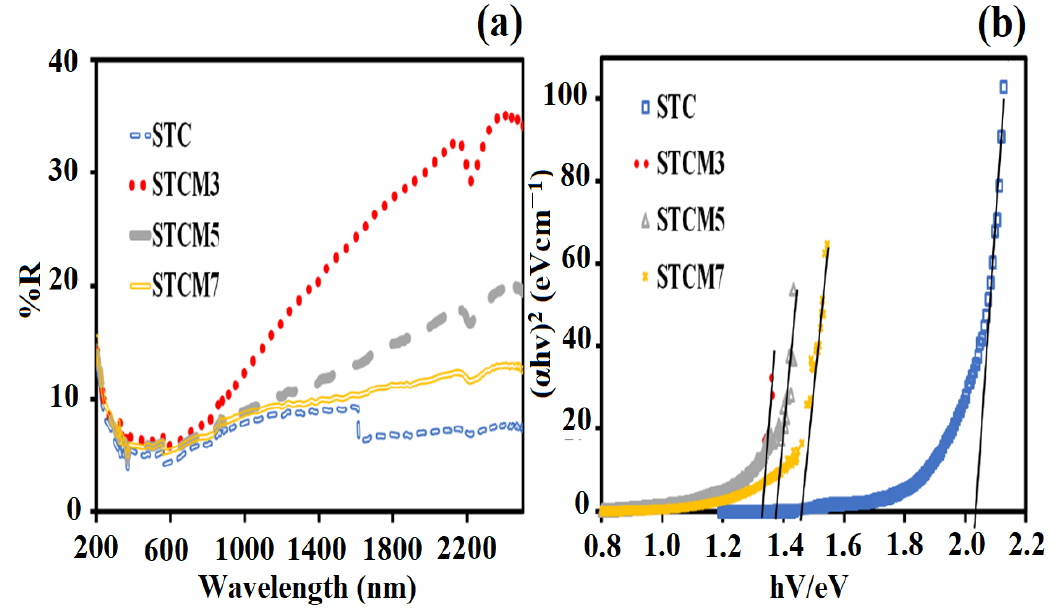
Figure 6. Results ( a ) UV–Vis NIR reflection spectroscopy and corresponding ( b ) Tauc plots and determination of band gaps of the STC and STCM materials. Table 2. The band energy of the STC and STCM materials. Samples Band Gap Values (eV)